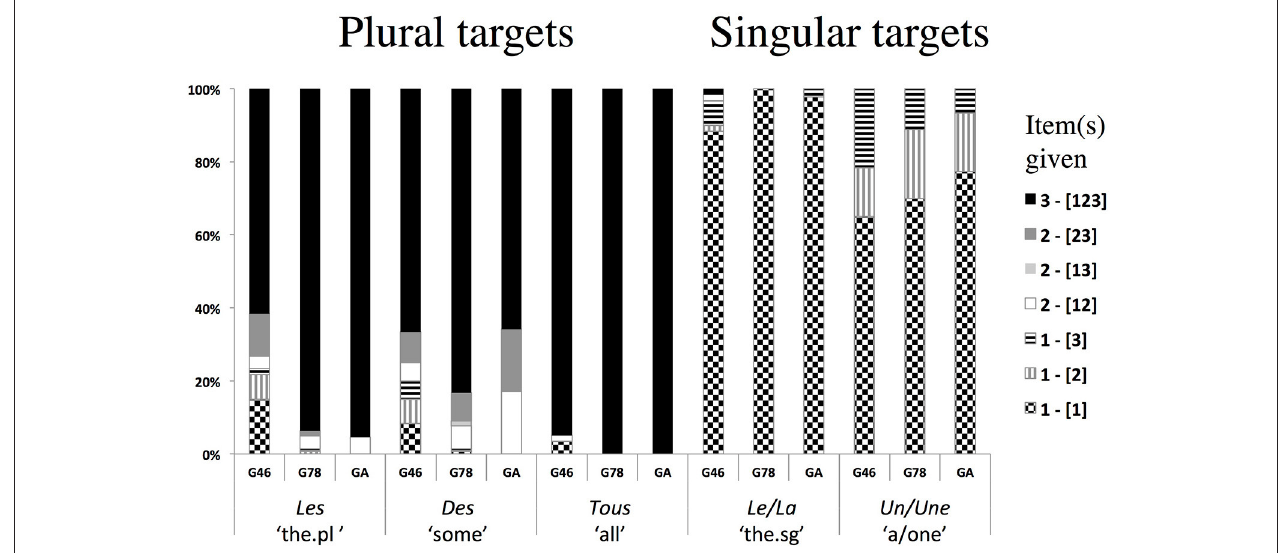
FIGURE 5 | Proportion of response types by GROUP and CONDITION . Conditions are des (indefinite plural), les (definite plural), tous les (explicit definite plural), le/la (definite singular, masculine or feminine), and un/une (indefinite singular, masculine or